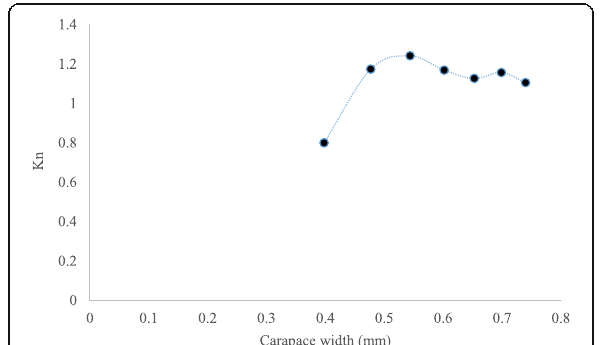
Fig. 4 Relative condition factor of H. marsupialis from Gulf of Aqaba, Red Sea, Egypt